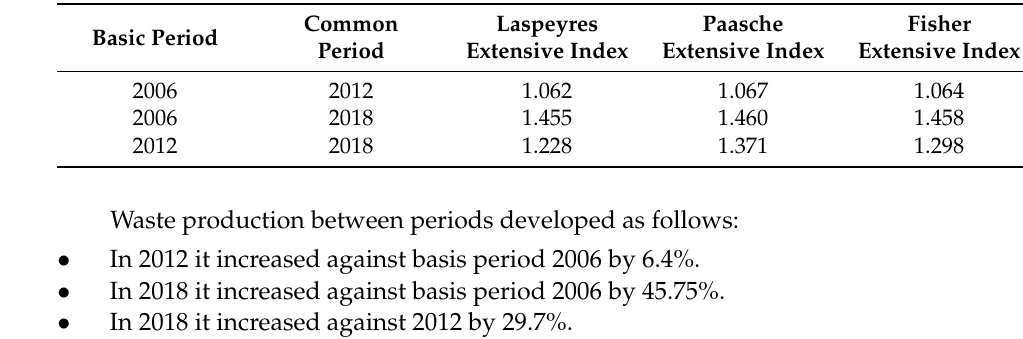
Table 1. Indexes of communal waste production according to